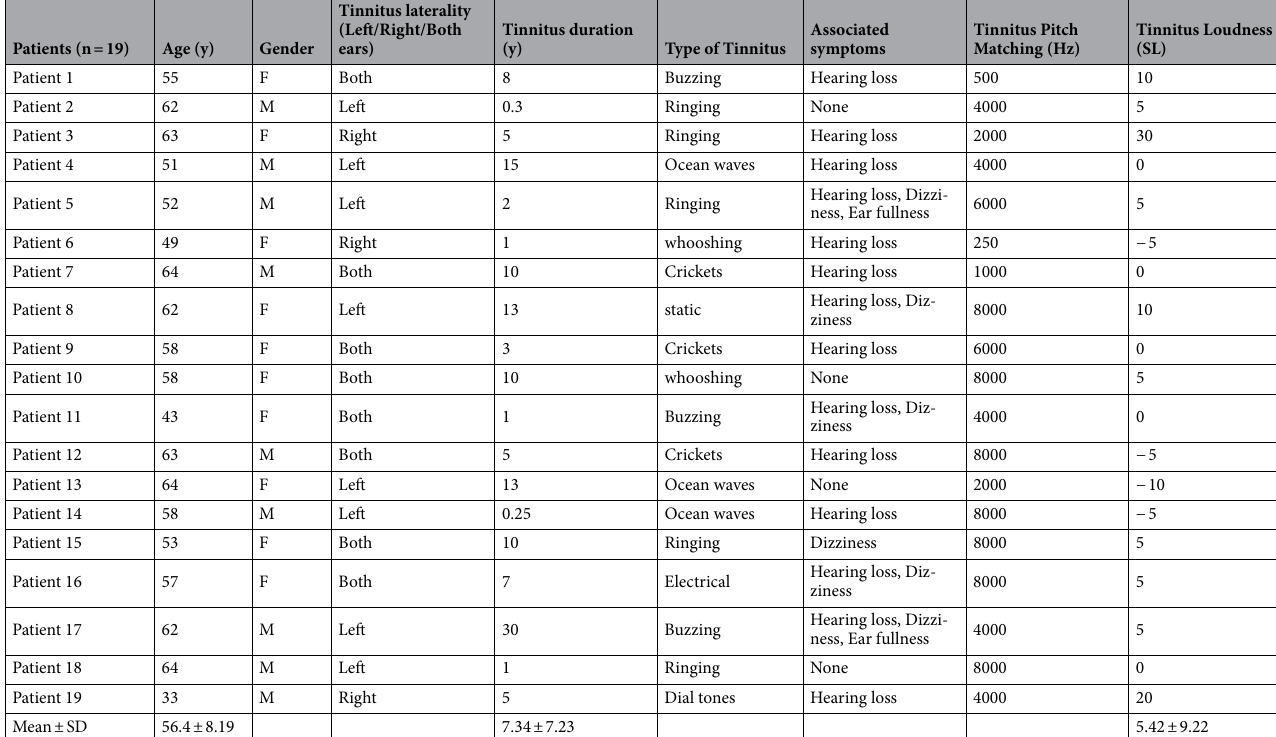
Table 2. Patients demographics and clinical